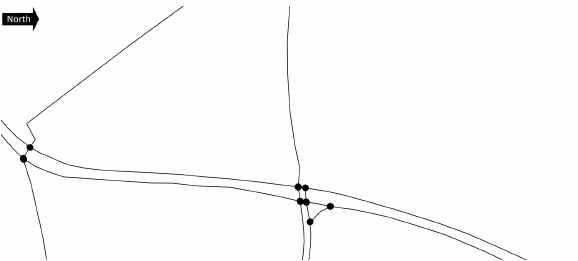
Figure 5. Relevant intersections between roads with higher cat-